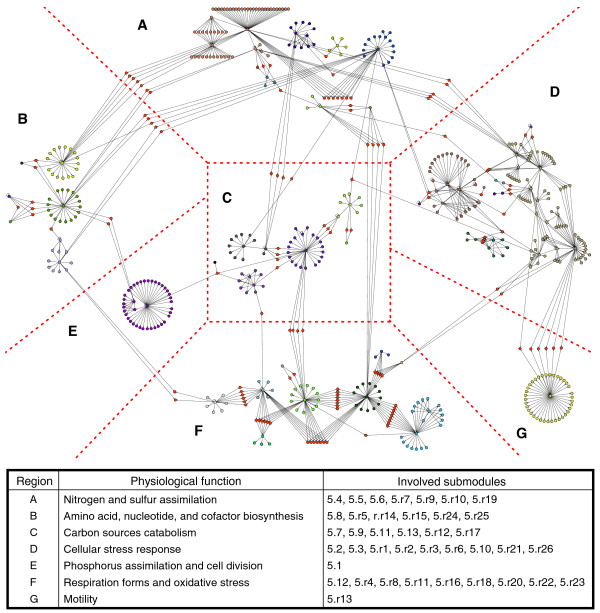
Empirical grouping, into seven regions, of submodules comprising the megamodule. Each color represents a submodule, while intermodular genes are shown in orange. Intermodular genes are placed inside the region that best associates with its most important physiological function. For example, the intermodular gene amtB, positively regulated by NtrC (region A) and GadX (region D), encodes an ammonium transporter under acidic growing conditions. Therefore, this gene was placed in the nitrogen and sulfur assimilation region (region A).